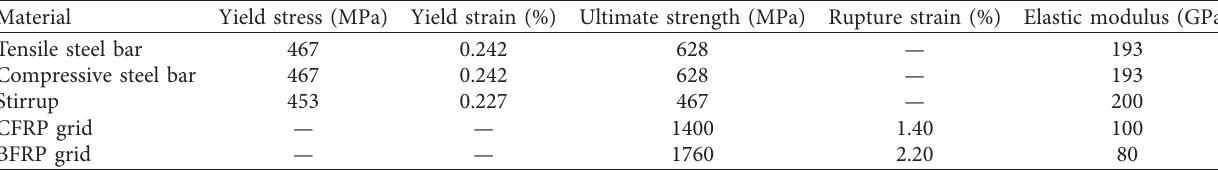
Table 5: Mechanical properties of materials